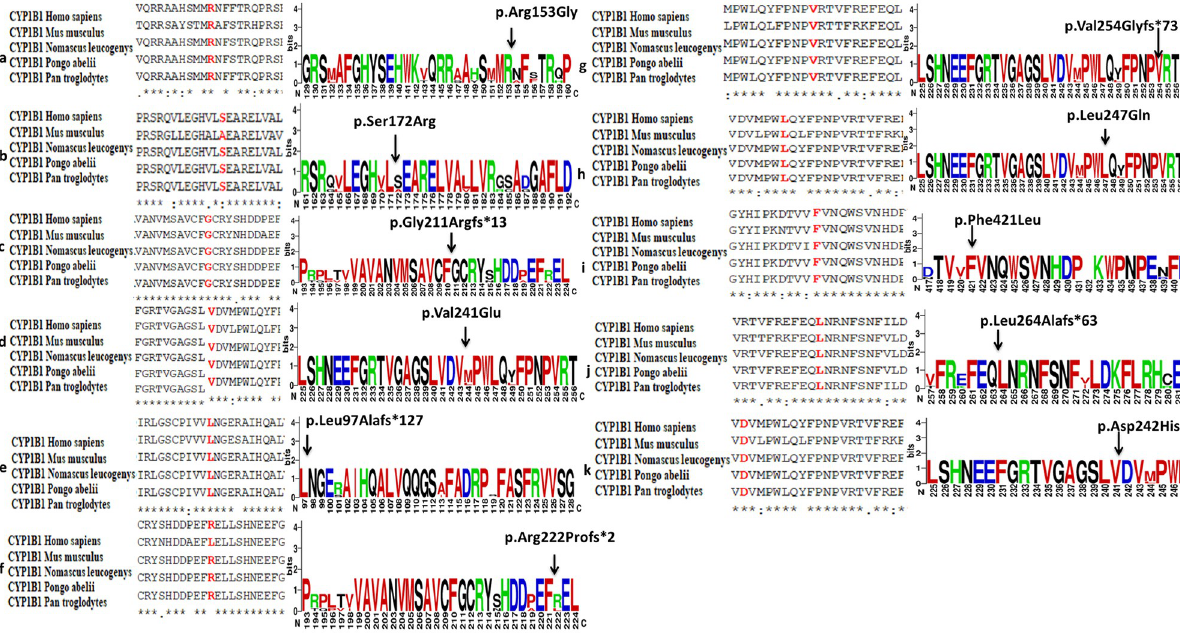
Fig 4. A comparison of CYP1B1 gene conservation among different homologs for novel variants detected in this study. a) Clustal Omega multiple sequence alignment (MSA) (Shown in red) for p.Arg153Gly detected in PCG049. b) Multiple sequence alignment (MSA) for p. Ser172Arg among homologs detected in PCG049 showing less conservation in Mus musculus . c) MSA result for p.Gly211Argfs � 13 among homologs detected in PCG050. d) MSA result for variant p.Val241Glu detected in PCG052. e) MSA result for p.Leu97Ala � 127 among homologs detected in PCG053. f) MSA result for p.Arg222Profs � 2 detected in PCG054 showing less conservation in Mus musculus . g) MSA result for variant p.Val254Glyfs � 73 detected on PCG059 showing complete conservation among homologs. h) MSA result for p. Leu247Gln among homologs detected in PCG060. i) MSA result for p. Phe421Leu detected in PCG062. j) MSA result for p.Leu264Alafs � 63 detected in PCG063. k) MSA result for p.Asp242His detected in PCG067. a-k) WebLogo results of all novel CYP1B1 protein variants showing comparison of conservation among homologs are on right side of the figure. All the variants except p.Ser172Arg and p.Arg222Profs � 73 show 100% conservation among different mammals (Large size of amino acid abbreviation letter show full conservation while small size show less conserved position among